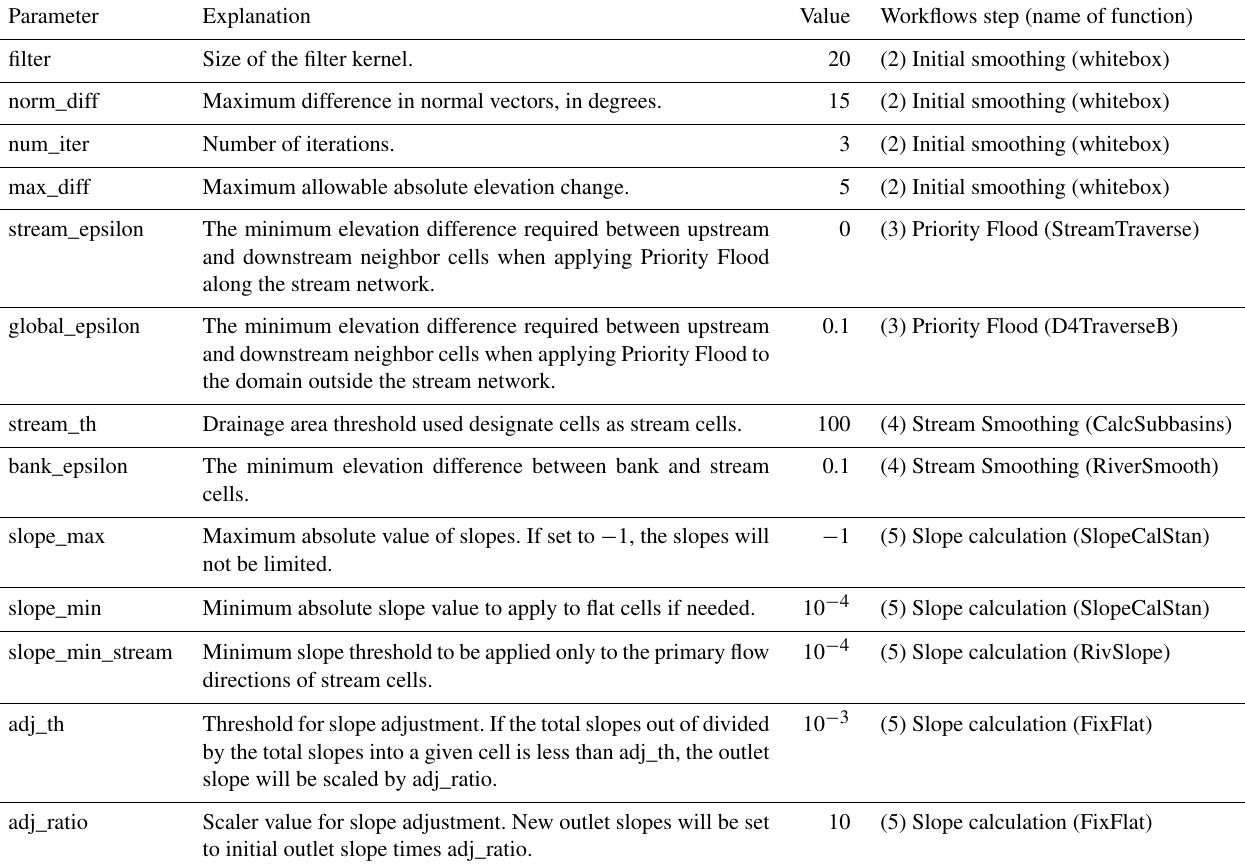
Table 1. Parameters for the topographic processing and values in this dataset. Parameter Explanation Value Workflows step (name of